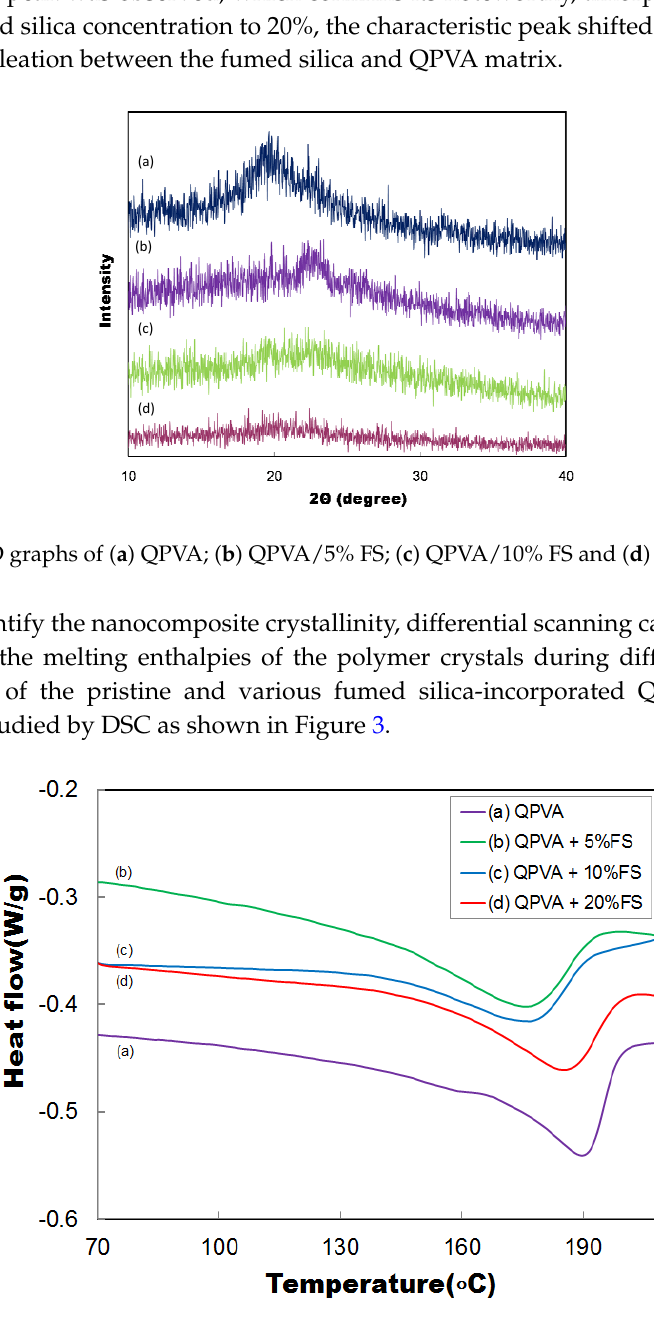
Figure 3. DSC graphs of ( a ) QPVA; ( b ) QPVA/5% FS; ( c ) QPVA/10% FS and ( d ) QPVA/20% FS.